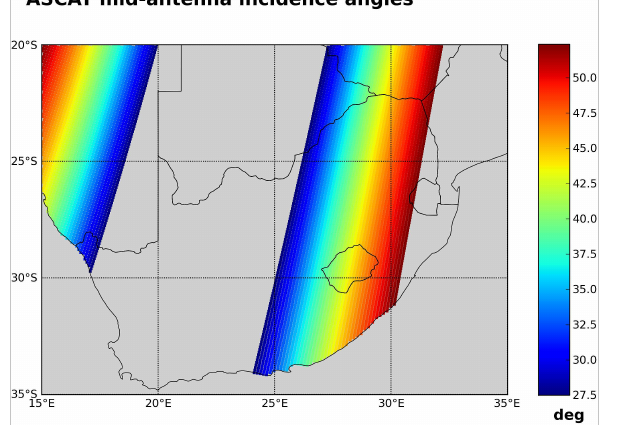
Fig. 20. Averages of five months of the SSM absolute error esti- Fig. 19. Incidence angle (in decimal degrees) for the middle antenna Fig. 19. Incidence angle (in decimal degrees) for the middle antenna of the ASCAT instrument. mates provided with the ASCAT product by EUMETSAT. The re- The satellite overpass time matches that shown in Fig. 9. of the ASCAT instrument. The satellite overpass time matches that ported error estimates have been averaged over 0.25 ◦ blocks for shown in Fig. 10. each overpass and the time average for each block 41